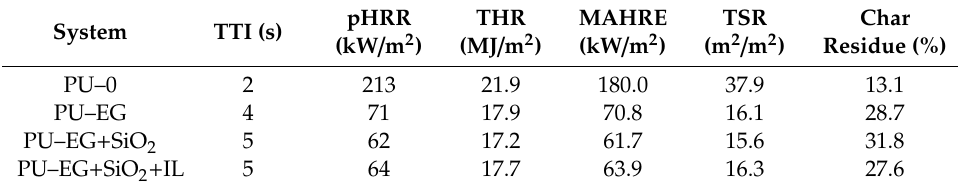
Table 5. Parameters determined during the combustion process of